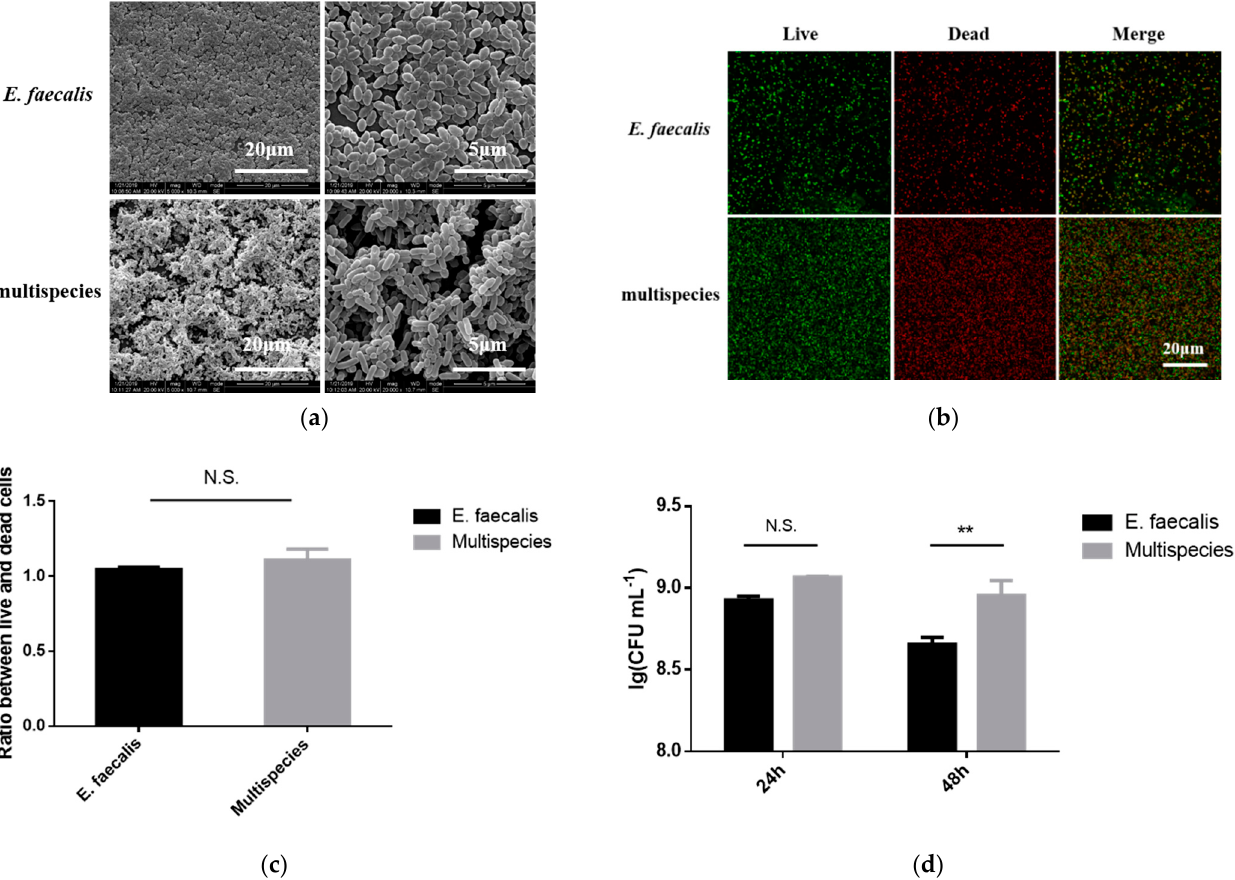
Figure 4. The biofilm formation of E. faecalis and multispecies models. ( a ) The scanning electron microscopy images of E. faecalis and multispecies biofilms with 5000× and 20,000× magnified visual fields; ( b ) the live/dead bacterial staining image of biofilms (live bacteria, stained green; dead cells, stained red); ( c ) the ratio of the live bacteria cells to dead cells was computed in line with 3 random sights of biofilms; ( d ) colony-forming units of bacteria in biofilms formed by E. faecalis and multispecies ( n = 3). Data are presented as the mean ± standard deviation (** p < 0.01).